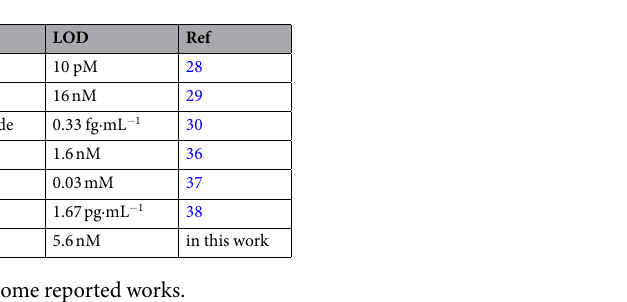
Table 1. MOFs as biosensors in some reported